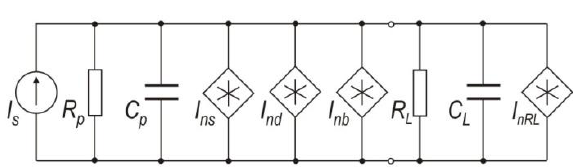
Figure 9. PMT equivalent